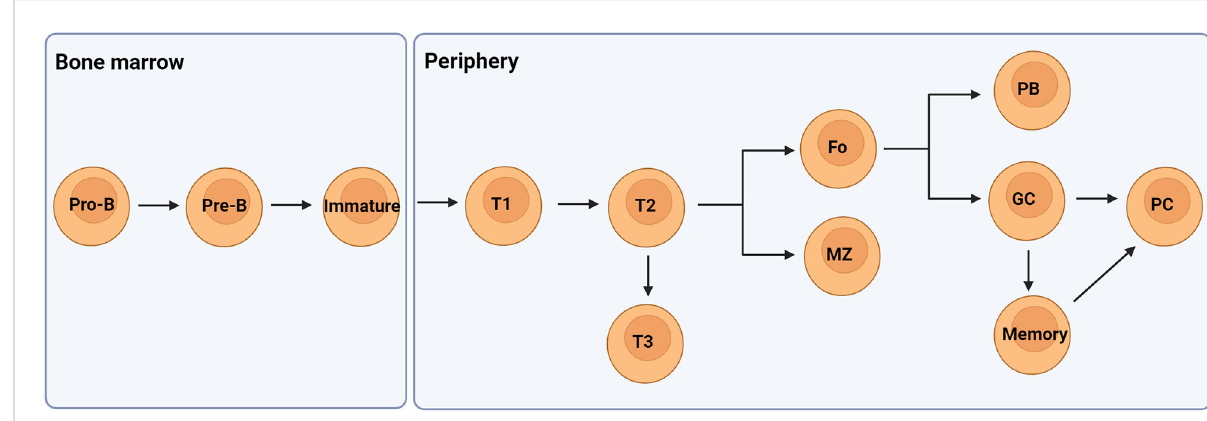
FIGURE 1 A simpli fi ed overview of the developmental pathway of B cells. They develop in the bone marrow from hematopoietic stem cells to pro- and pre-B cells once the IgH genes are rearranged. Following successful IgL gene rearrangement the cells develop to immature B cells expressing IgM. These cells then migrate from the bone marrow to the periphery as transitional 1 (T1) B cells which pass through peripheral checkpoints with most autoreactive B cells becoming anergic-like T3 cells. T2 cells can mature to become either follicular (Fo) or marginal zone (MZ) B cells expressing IgM and IgD. Fo B cells can differentiate to low af fi nity antibody producing plasmablasts (PB) or undergo class switching and af fi nity maturation in germinal centres (GC) to become high af fi nity antibody producing plasma cells or memory cells. Figure created with